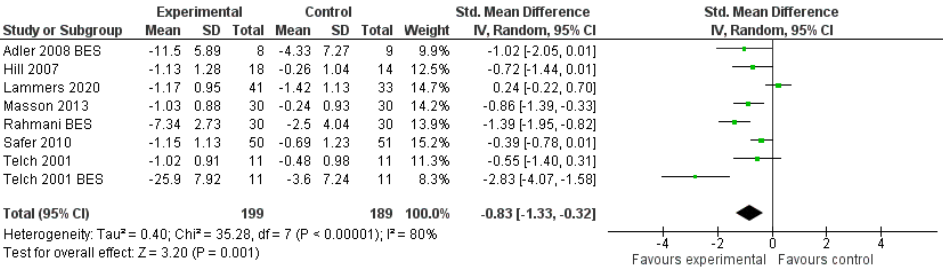
Figure 5. Forest plot: adjusted analysis of the severity of symptoms.